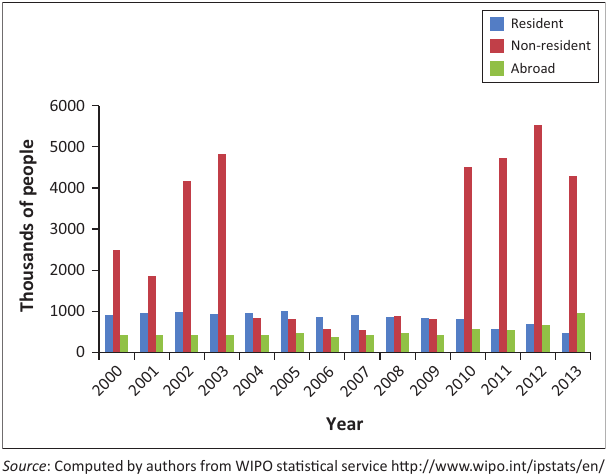
FIGURE 7: Patent grants by source for South Africa (thousands of people).